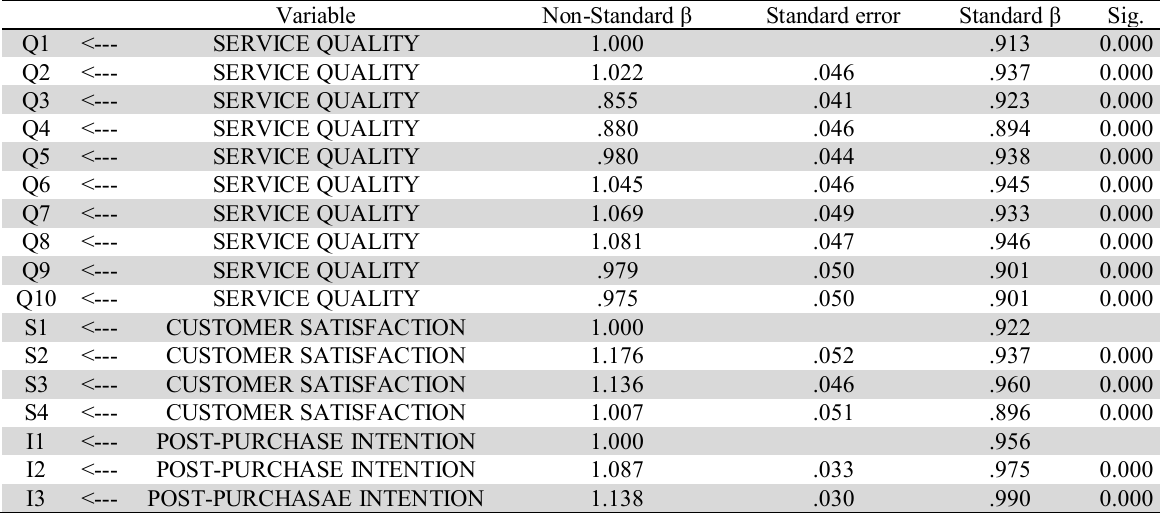
The summary of SEM statistics